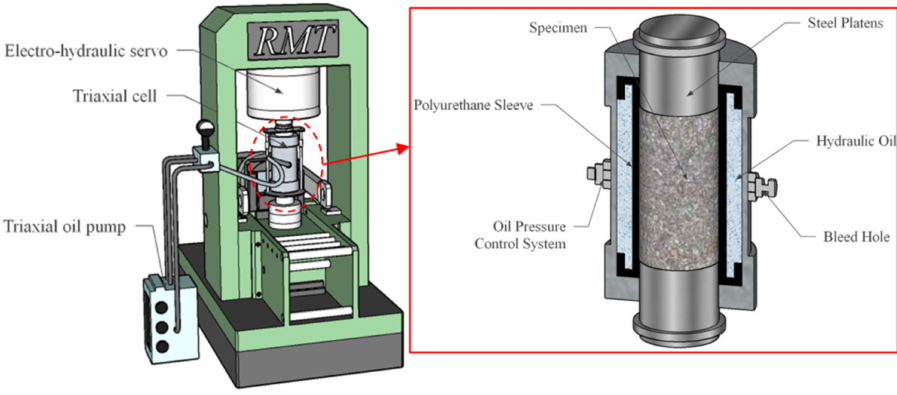
Figure 2. The pressure vessel assembly for the triaxial test.